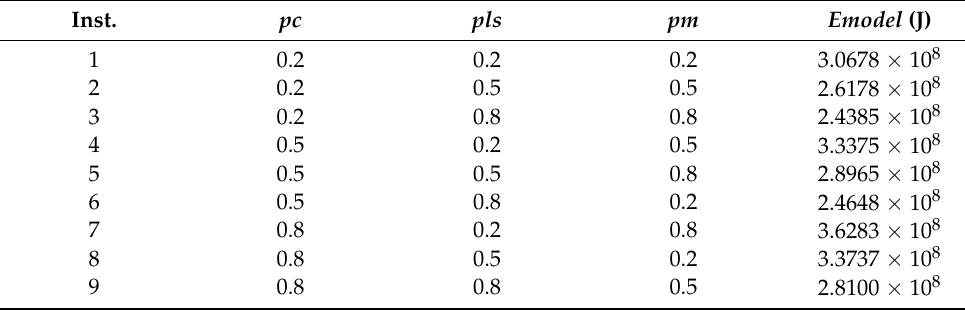
Table 3. The results of MA-IT with different parameter settings. Inst.